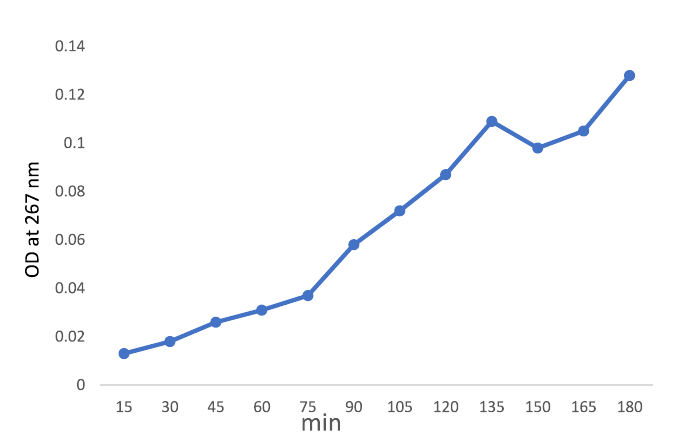
Fig. 2. Drug release pattern of PHB encapsulated coreshell SPIONs